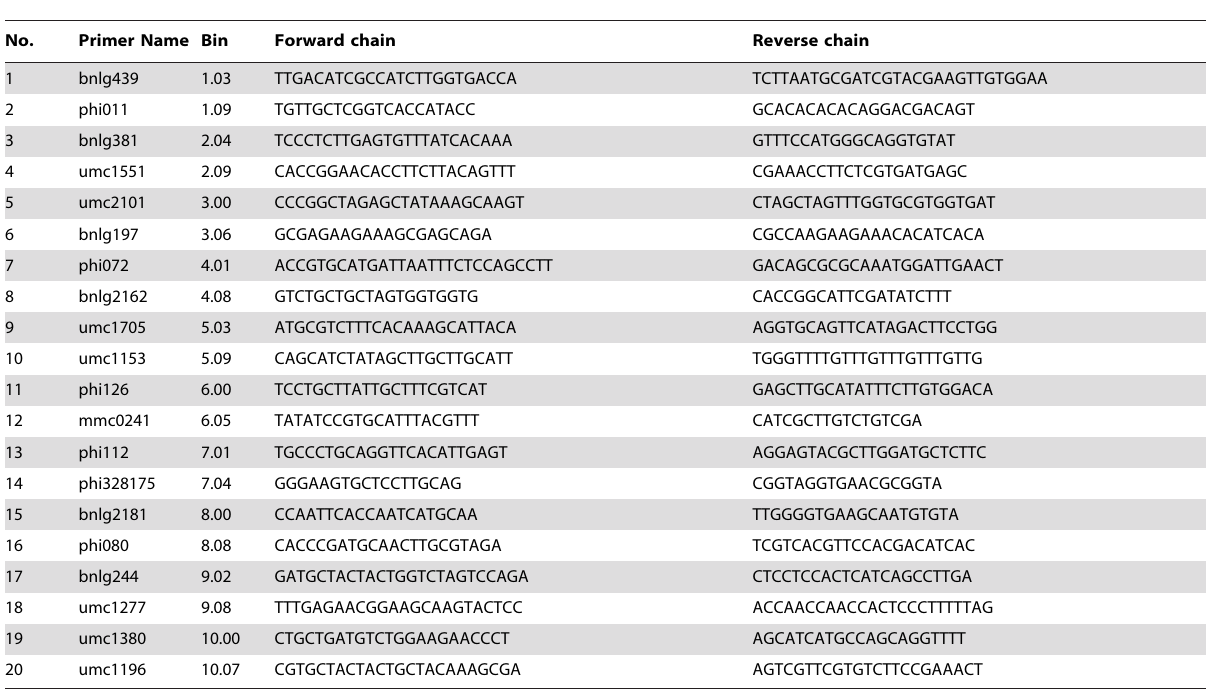
Table 1. Chromosome locations of SSR primers and primer